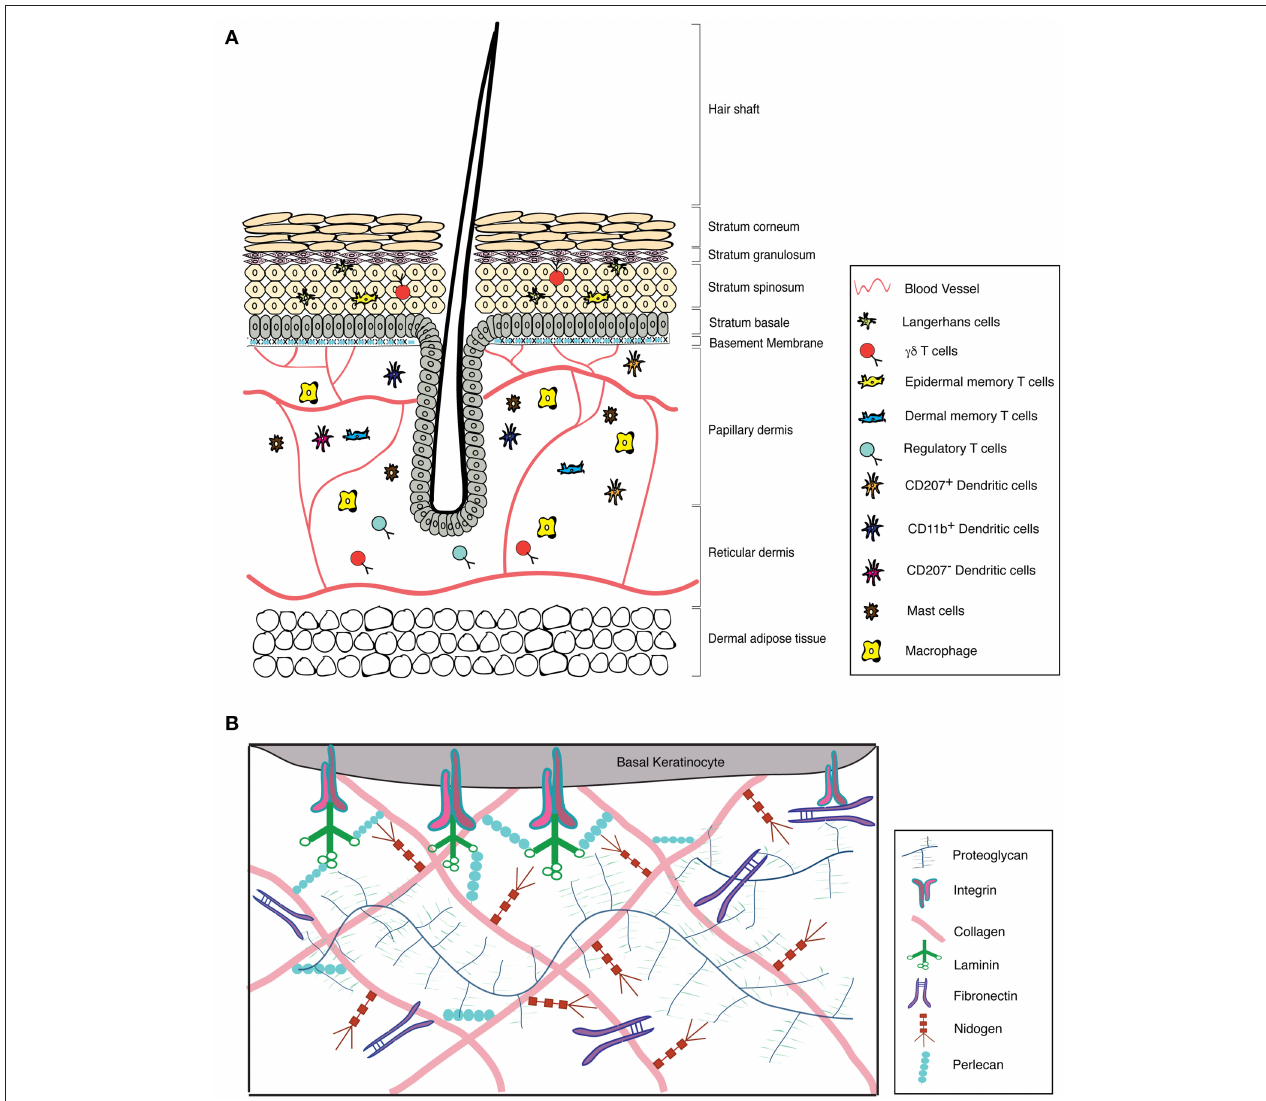
FIGURE 1 | Structure of the skin with its associated ECM and immune cell repertoire. (A) Structure of the skin and its immune components. (B) Graphical representation of the major components of the skin ECM.